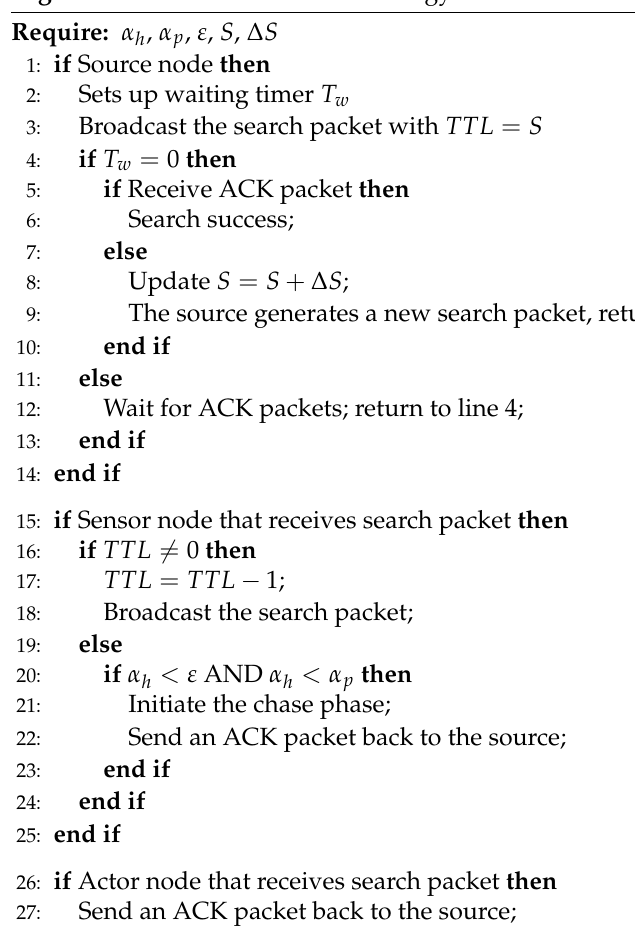
Algorithm 1 Trail-based Search Strategy: Search